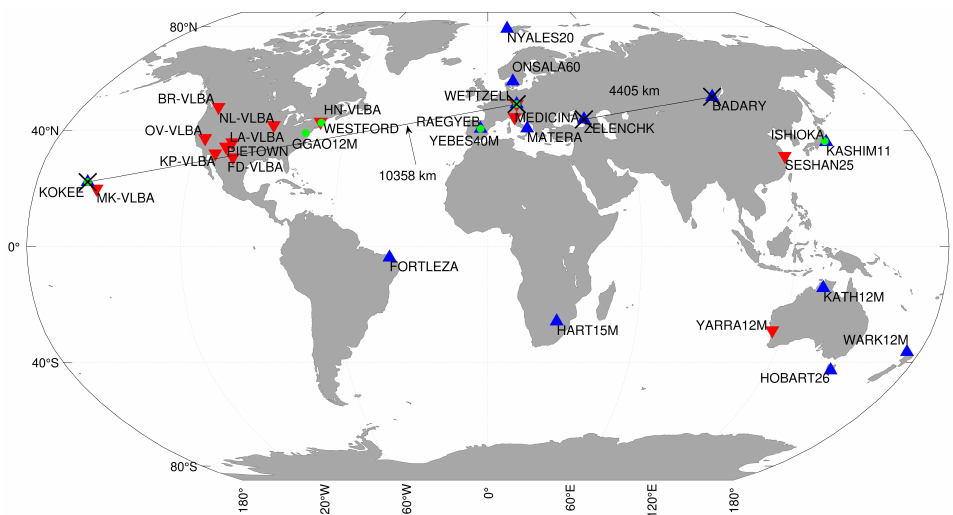
Figure 1. Geographical representation of the stations of the various networks: legacy (S/X) stations in Legacy-1 network stations (upward triangle), Legacy-2 network stations (downward triangle); VGOS stations (green circle); stations that participate in Intensives are indicated by a black cross, and their baselines are represented by a black solid